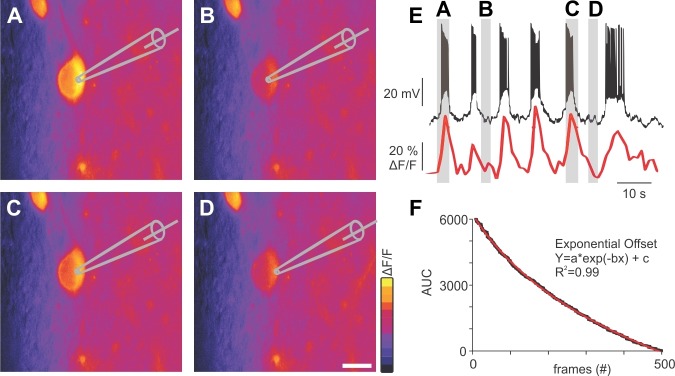
Ca2+oscillations correlate highly with membrane voltage oscillations in TIDA neurons.(A-D) Calcium images from a single TIDA neuron in different time points. Dark colours represent low-calcium activity, brighter colors represent high-calcium activity in the cell, scale bar is 10 µm. (E) Simultaneous calcium imaging and whole-cell in DAT-GCaMP3 mouse TIDA neuron. Shadow areas refer to the previous images at a peak of florescence (A and C, high-calcium activity) and low fluorescence (B and D, low-calcium activity). (F) Bleach correction by exponential frame subtraction performed with Image J EMBL tools.